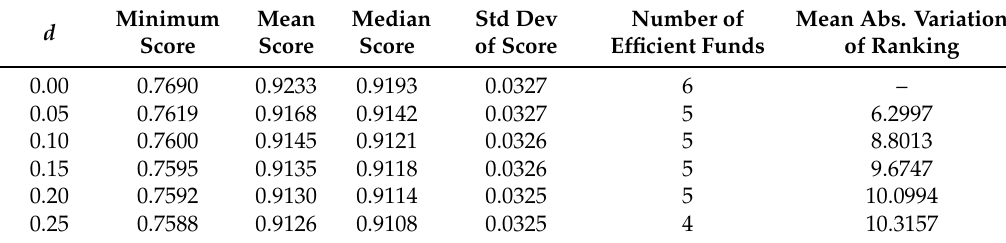
Table 6. Main results for the VW restrictions with constraints only on the target DMU in the case of symmetric bounds and T = 1. Summary statistics on the performance scores (minimum, mean and median values, standard deviation), number of efficient funds and mean absolute variation (divided by 2) of the ranking positions.